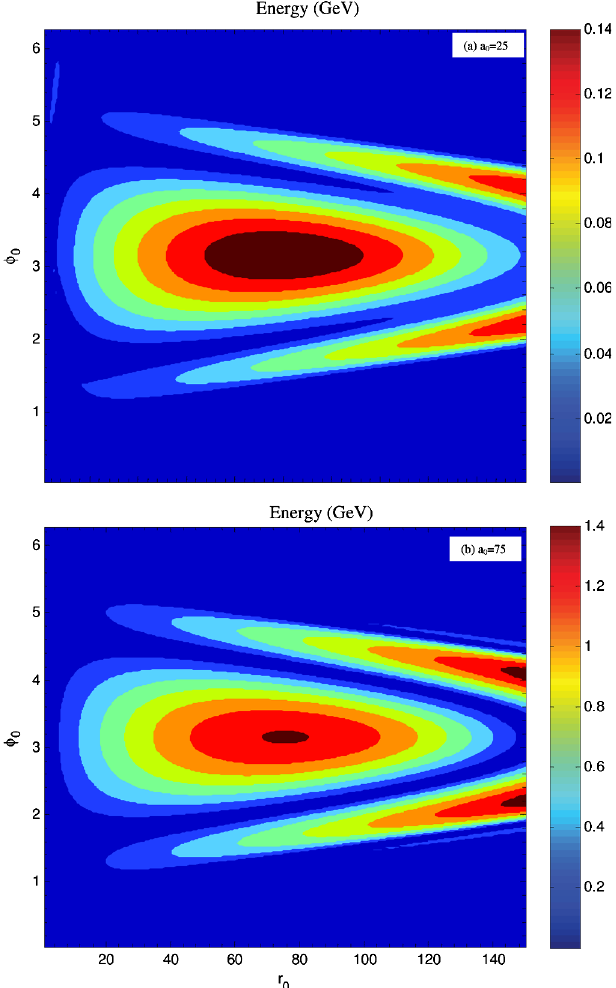
FIG. 6. Electron energy (in GeV) distribution as a function of normalized r 0 and (cid:1) 0 for (a) a 0 ¼ 25 , and (b) a 0 ¼ 75 . Other parameters are r i ¼ 0 , t 0 ¼ 0 , (cid:3) ¼ 200 , z L ¼ 0 , and 0 z 0 ¼